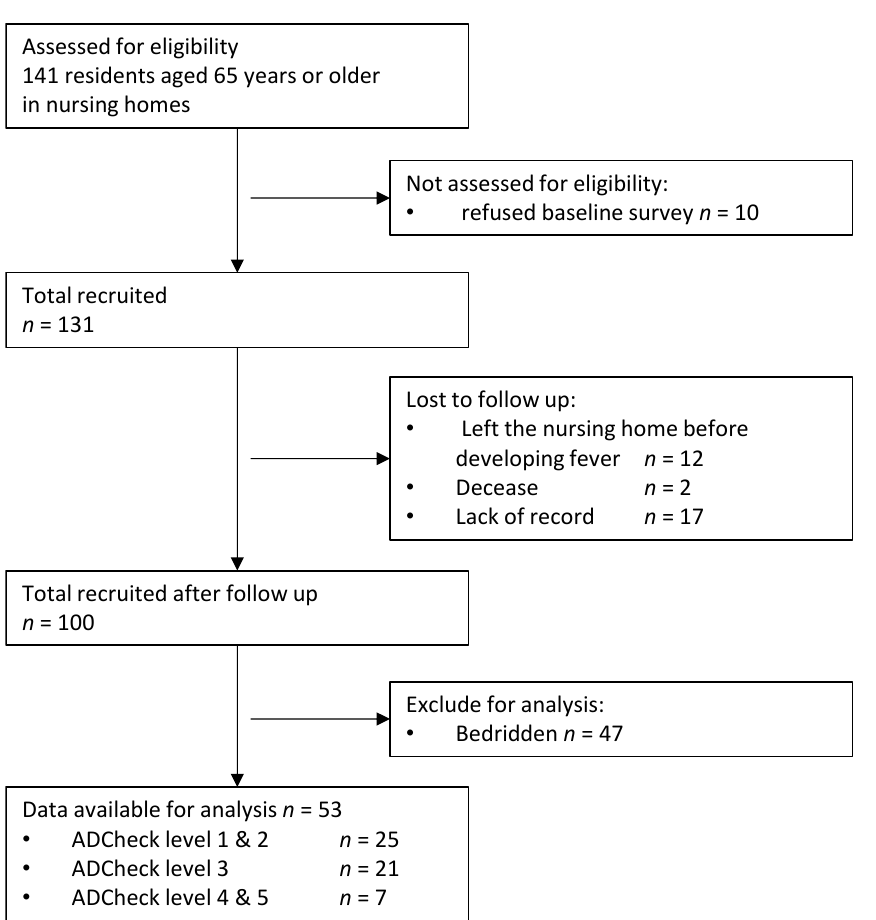
Figure 1. Flow diagram of the study participant